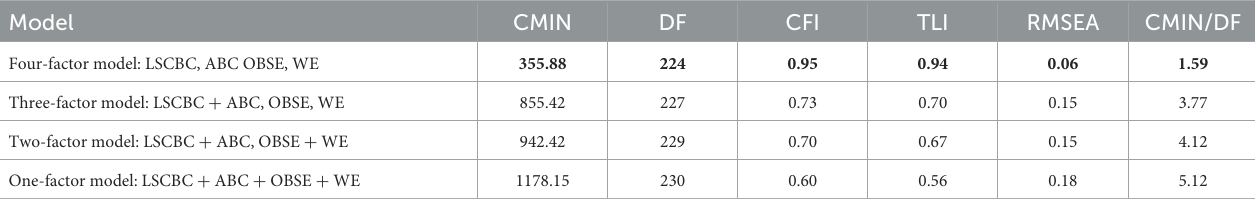
TABLE 1 Results of confirmatory factor analysis.